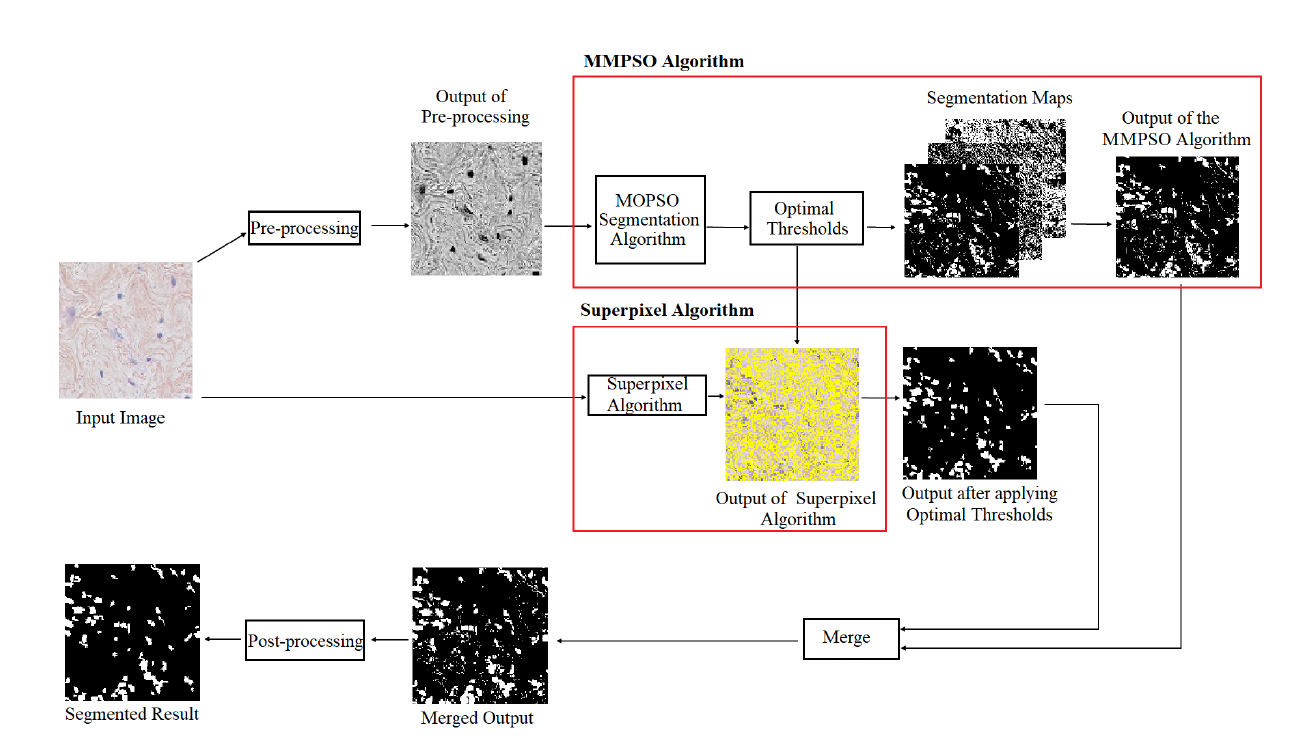
Figure 2. General representation of the proposed CAD system.